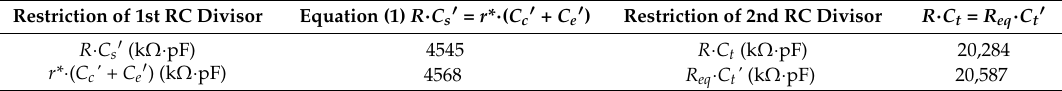
Table 2. Checking restrictions of Equations (10) and (11) for the built voltage sensor.